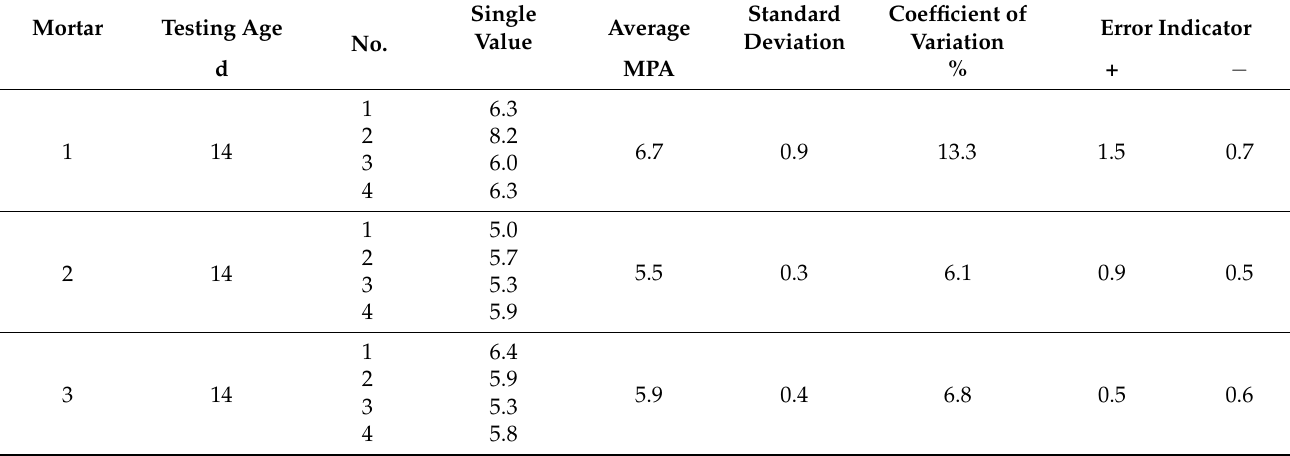
Table A7. Initial crack mortar stress, uniaxial tension test, carbon textile, Mortar